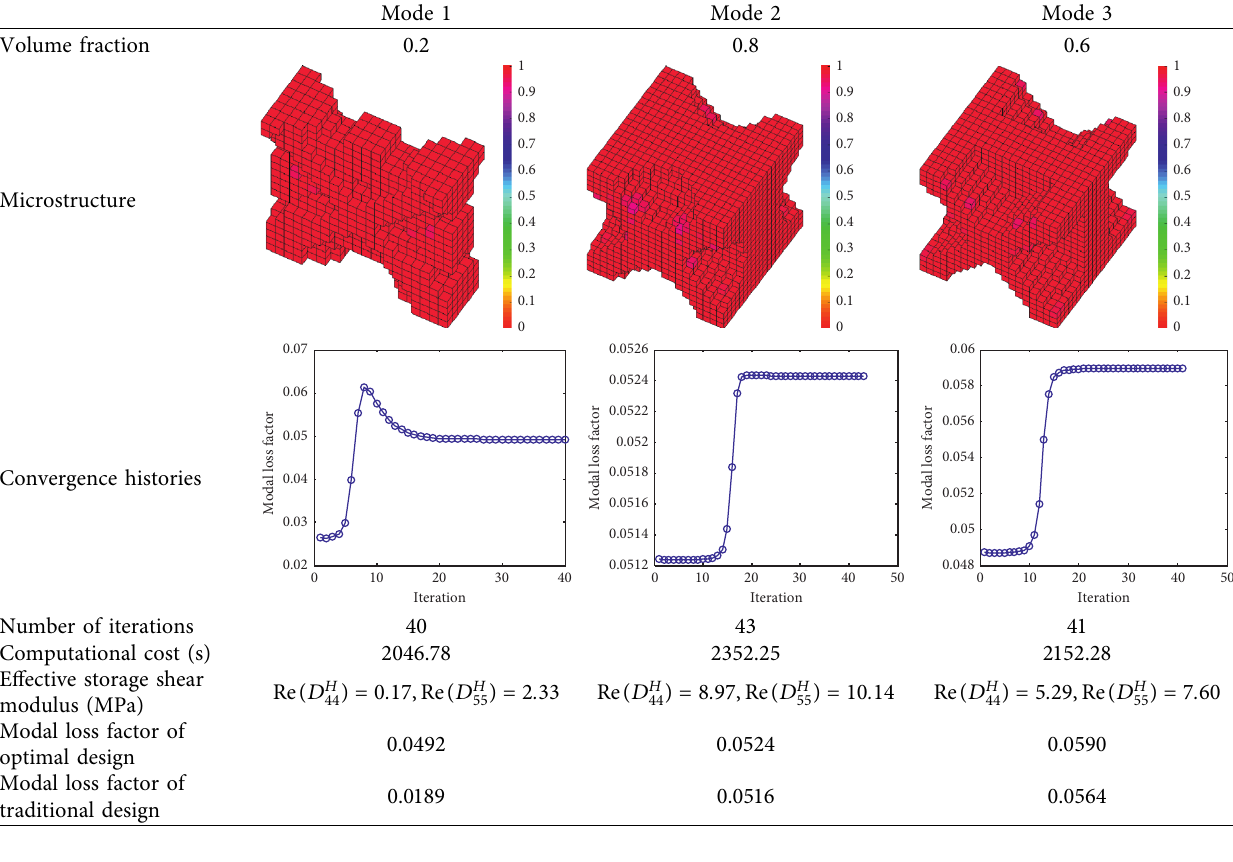
Table 8: Topological designs of viscoelastic damping material microstructures for maximizing modal loss factors with different volume